Question: Write a caption explaining this figure to a reader.
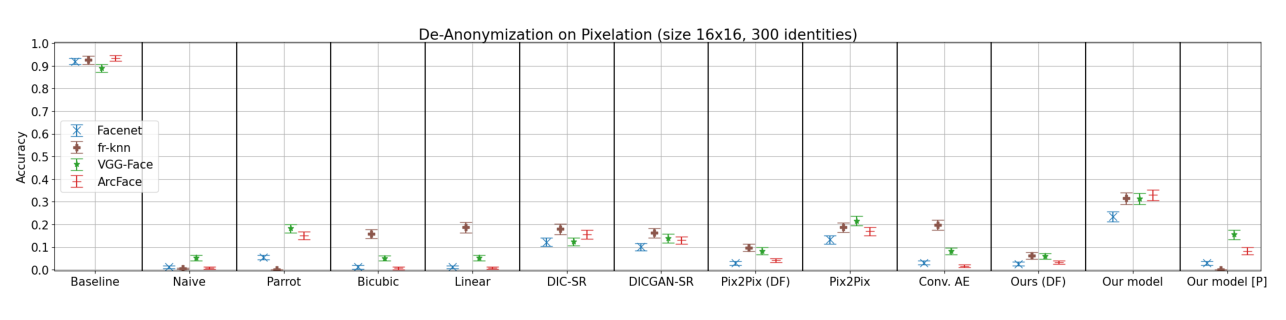
Answer: Recognition accuracy for Pixelation, given for baseline, naive, parrot, de-anon. via bicubic interpolation, via linear interpolation, via DIC-SR, via DICGAN-SR, via Pix2Pix trained on DigiFace-1M, via Pix2Pix, via our model without linear layer, via our model trained on DigiFace-1M, via our model; on 300 identities of CelebA.